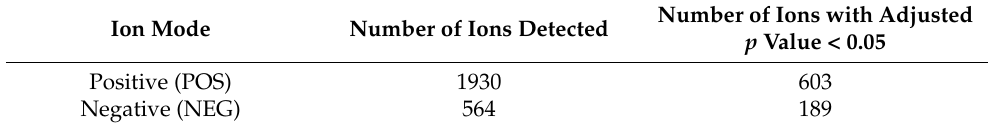
Table 2. The total number of ions detected and ions selected by statistical